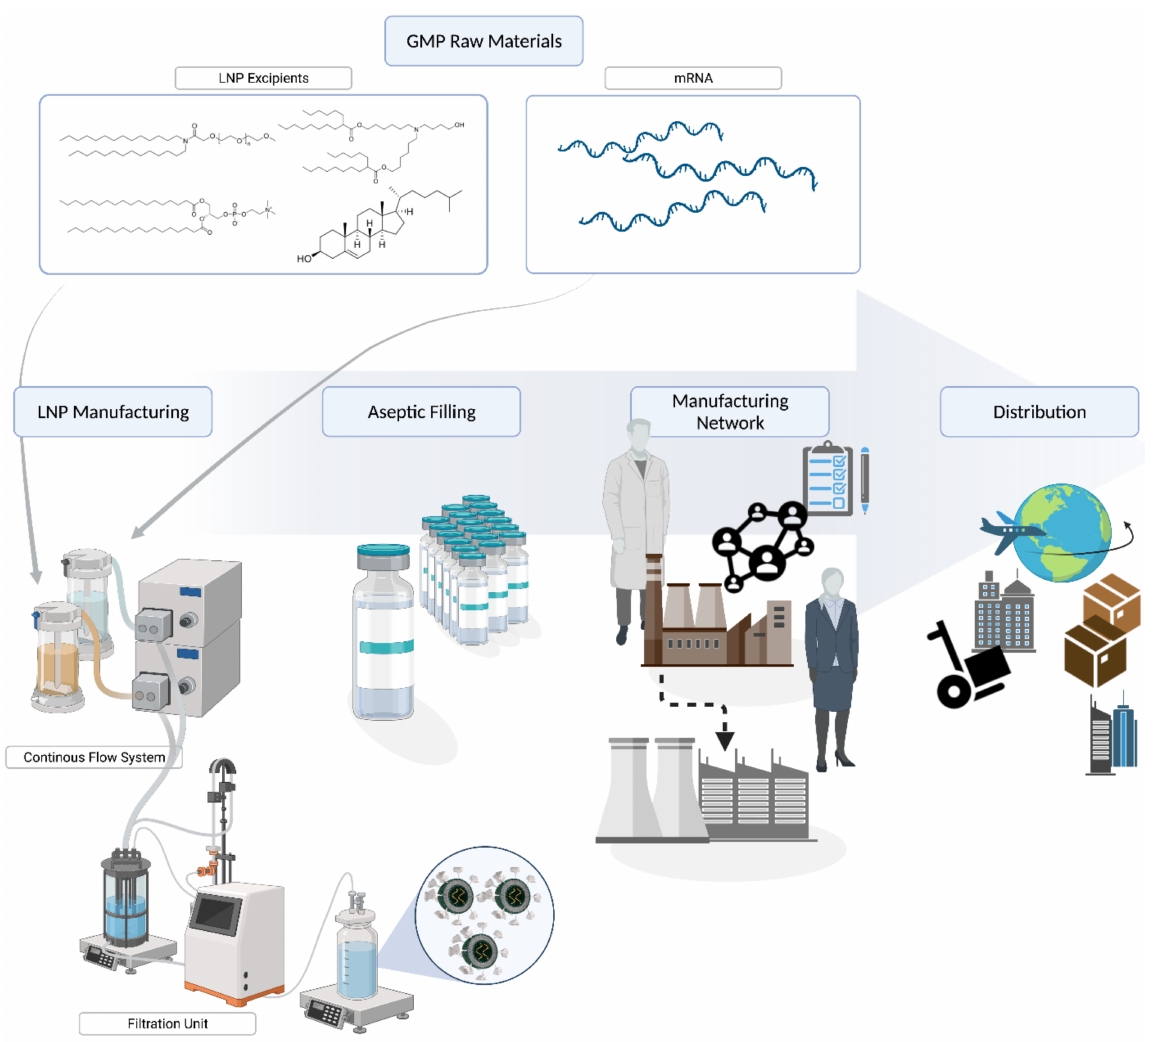
Figure 3. Manufacturing mRNA-LNP vaccines for COVID-19: From procurement of critical raw materials to LNP manufacturing and aseptic filling, expansion of manufacturing capacity, and distribution for